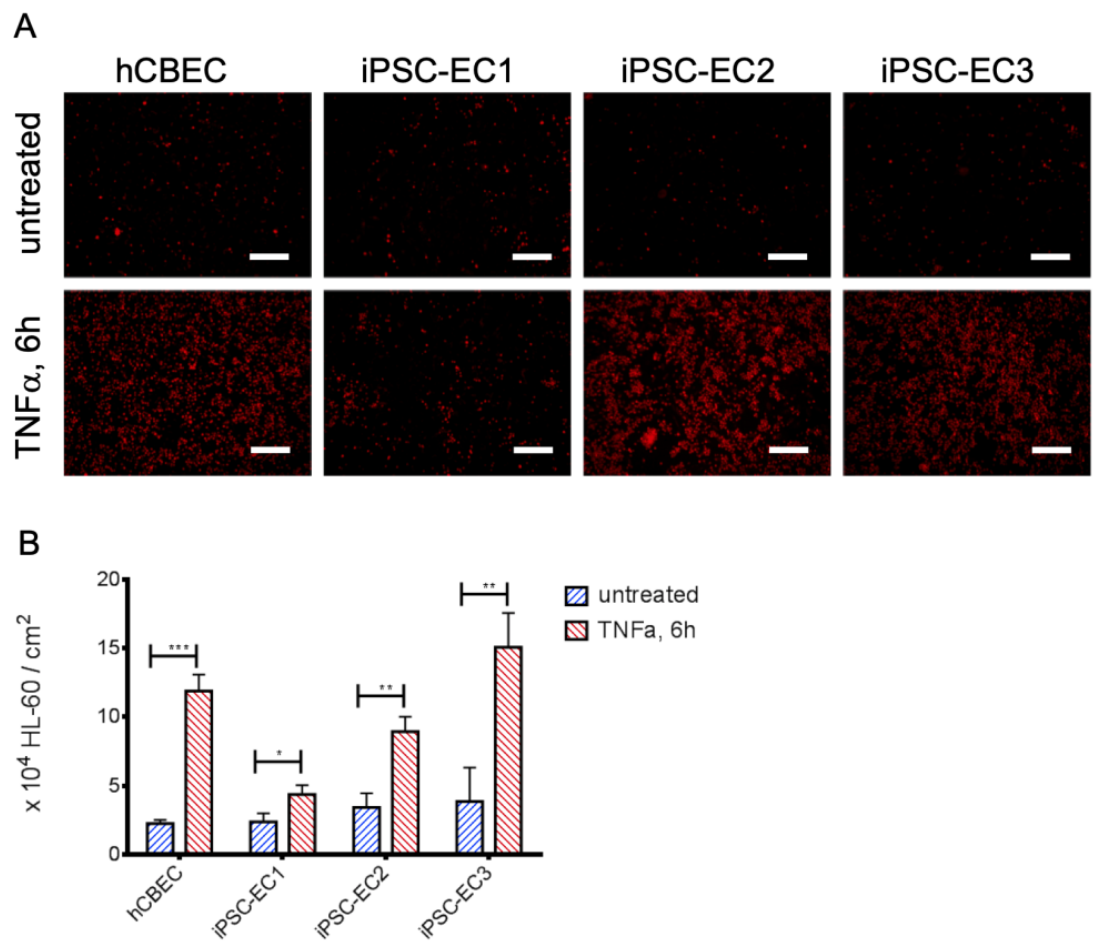
Figure 3. iPSC-ECs on PMP membranes show different levels of leukocyte adhesion after TNF α treatment. ( A ) Exemplary images of cell tracker red-stained HL-60 leukocytes (red) on iPSC-EC endothelialized gas exchange membranes under standard condition and after treatment with TNF α for 6 h. Except for monolayers established from iPSC-EC1s, appreciably increased numbers of HL-60 cells adhered to EC-monolayers incubated with TNF α . Scalebar: 250 µ m. ( B ) Quantification of adhered HL-60 leukocytes. Reported values are given as means ± standard deviation. Significant differences between untreated and TNF α -stimulated groups were marked with * at p < 0.05, ** when p < 0.01 and with *** when p <